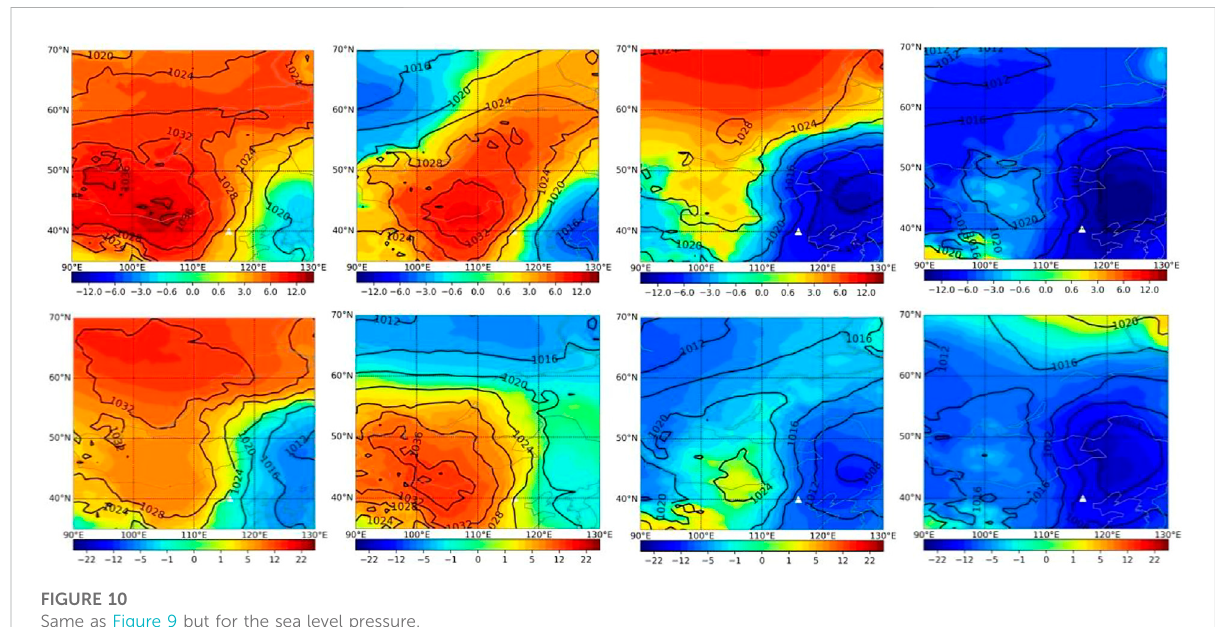
FIGURE 10 Same as Figure 9 but for the sea level